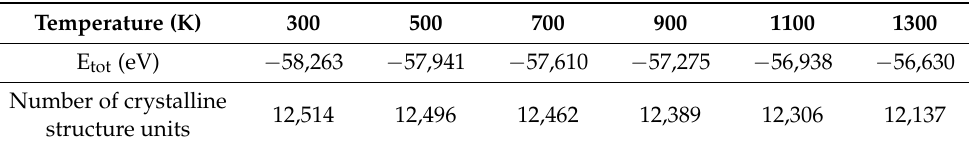
Table 1. Parameters associated with the structure of Fe 63 Ni 32 Co 5 alloy with 13,500 atoms at different temperatures. Temperature (K) 300 500 700 900 1100 1300 E tot (eV) − 58,263 − 57,941 − 57,610 − 56,630 Number of crystalline